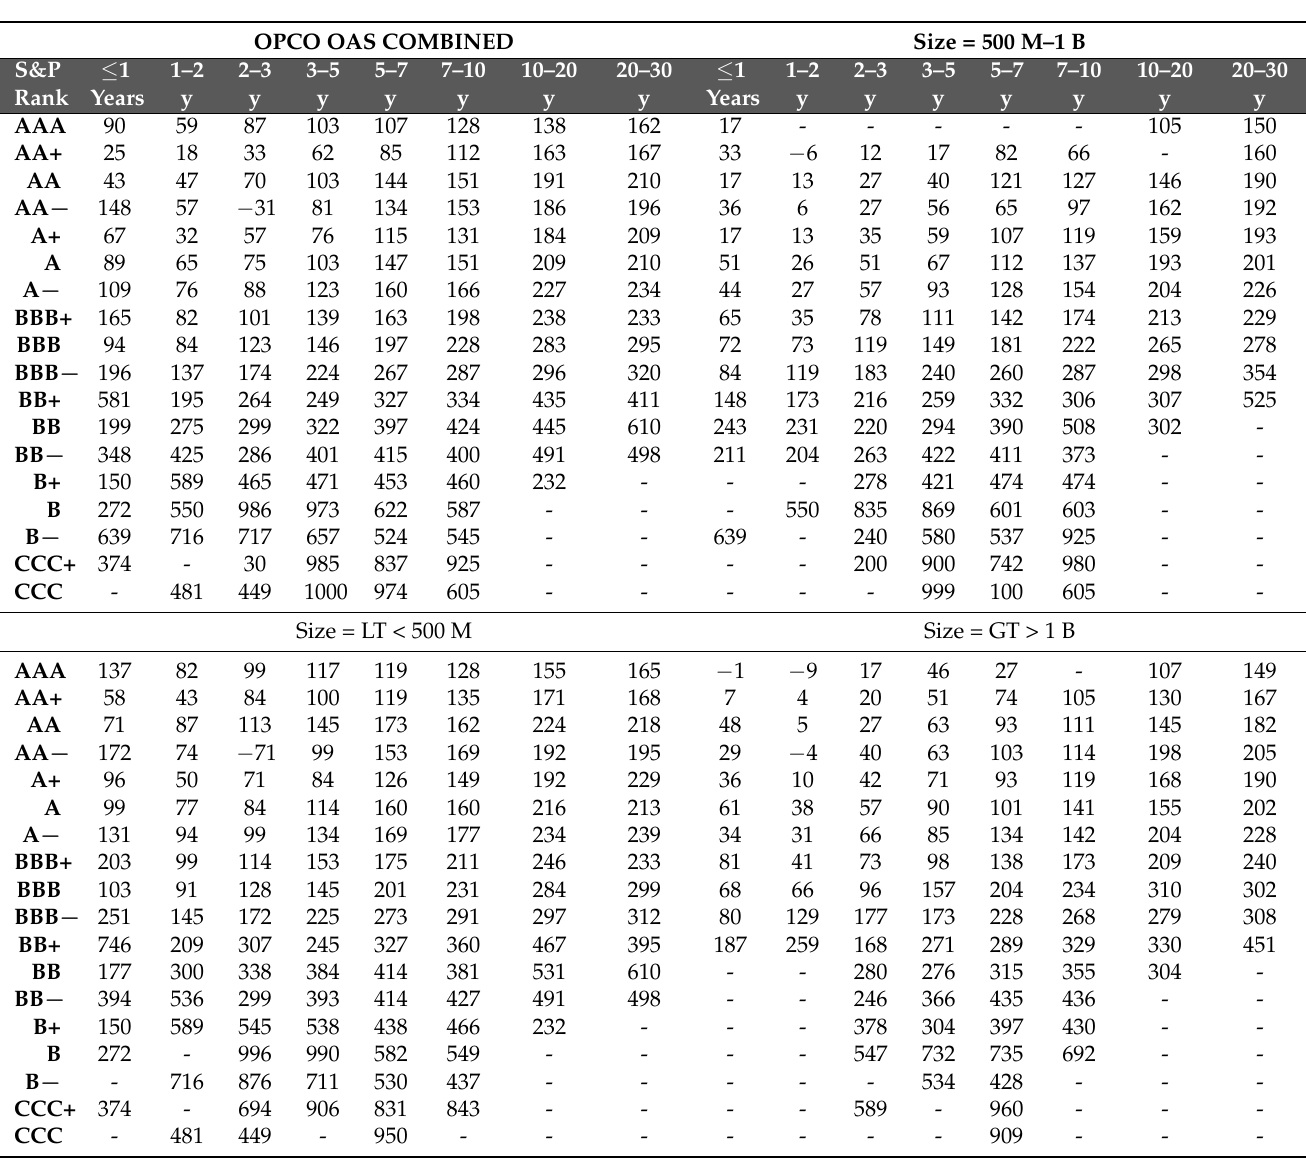
Table A1. Option-adjusted spreads table for U.S. operating companies, using S&P ranking and matching Treasury maturities. Cell values are the average OAS in basis points for the bonds in the cell (computed using Bloomberg—Fixed Income Worksheets, accessed on 26 September